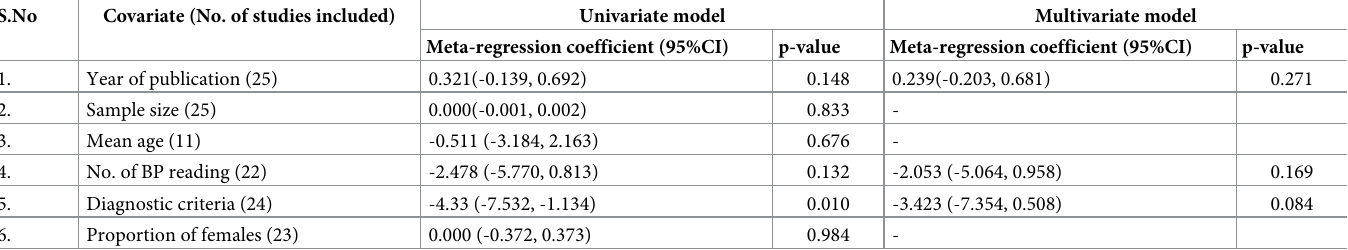
Table 4. Results for meta-regression for the prevalence of hypertension among